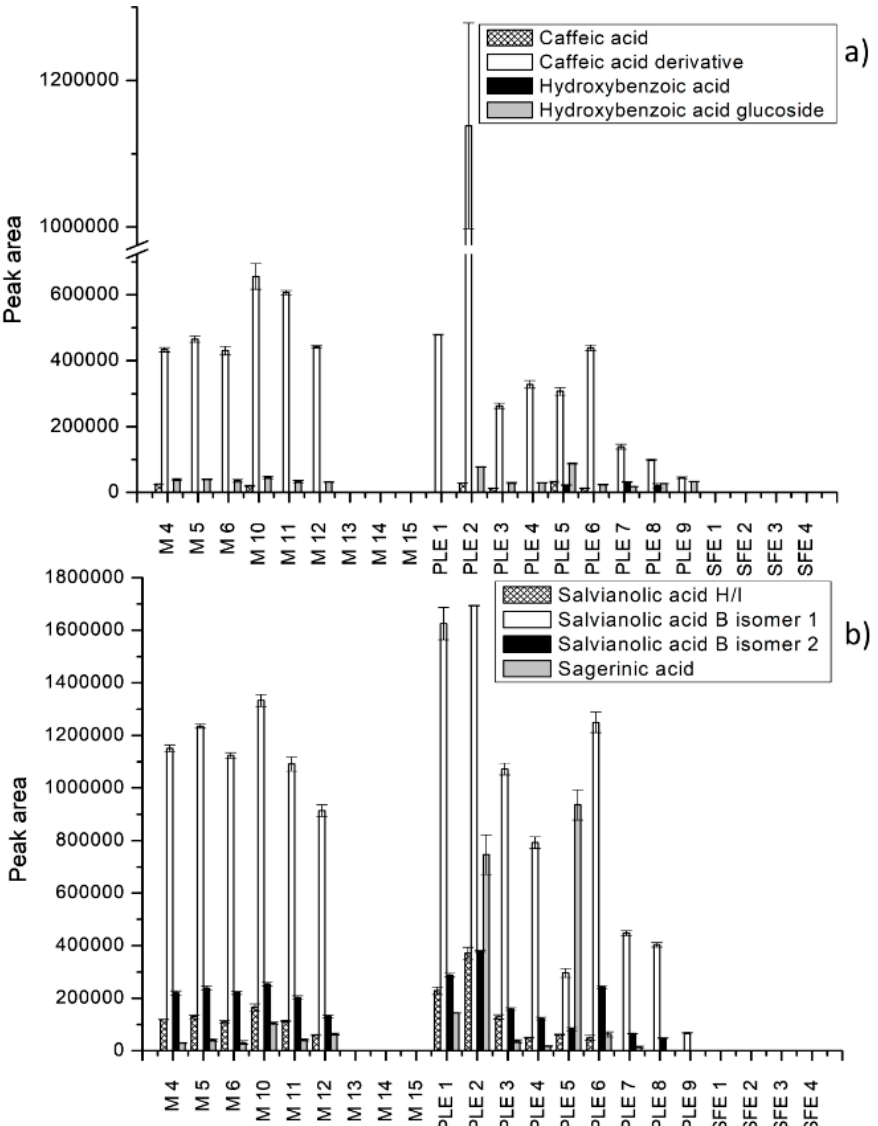
Figure 2. Extraction efficiency of different extraction techniques expressed as peak areas of phenolic acids. ( a ) Caffeic acid, caffeic acid derivative, hydroxybenzoic acid, and hydroxybenzoic acid glucoside; ( b ) salvianolic acid H/I, salvianolic acid B isomers, and sagerinic acid.